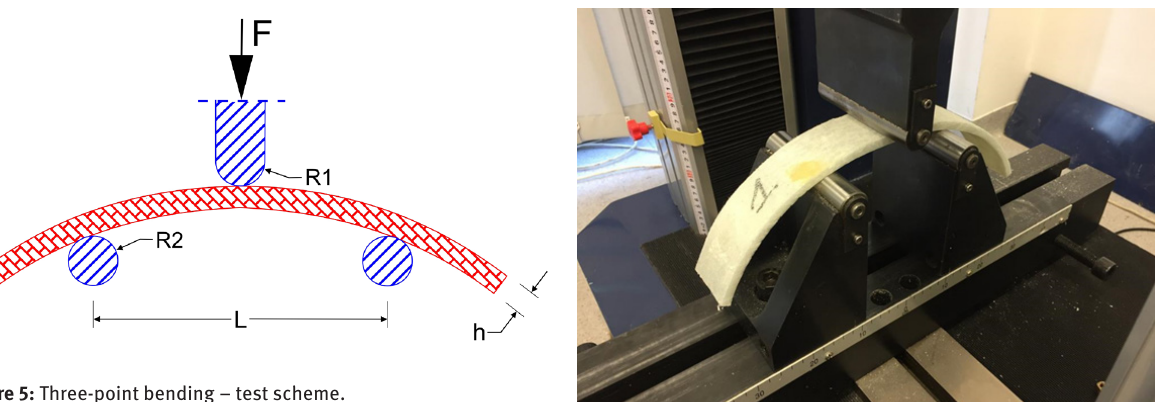
Figure 5: Three-point bending – test scheme.